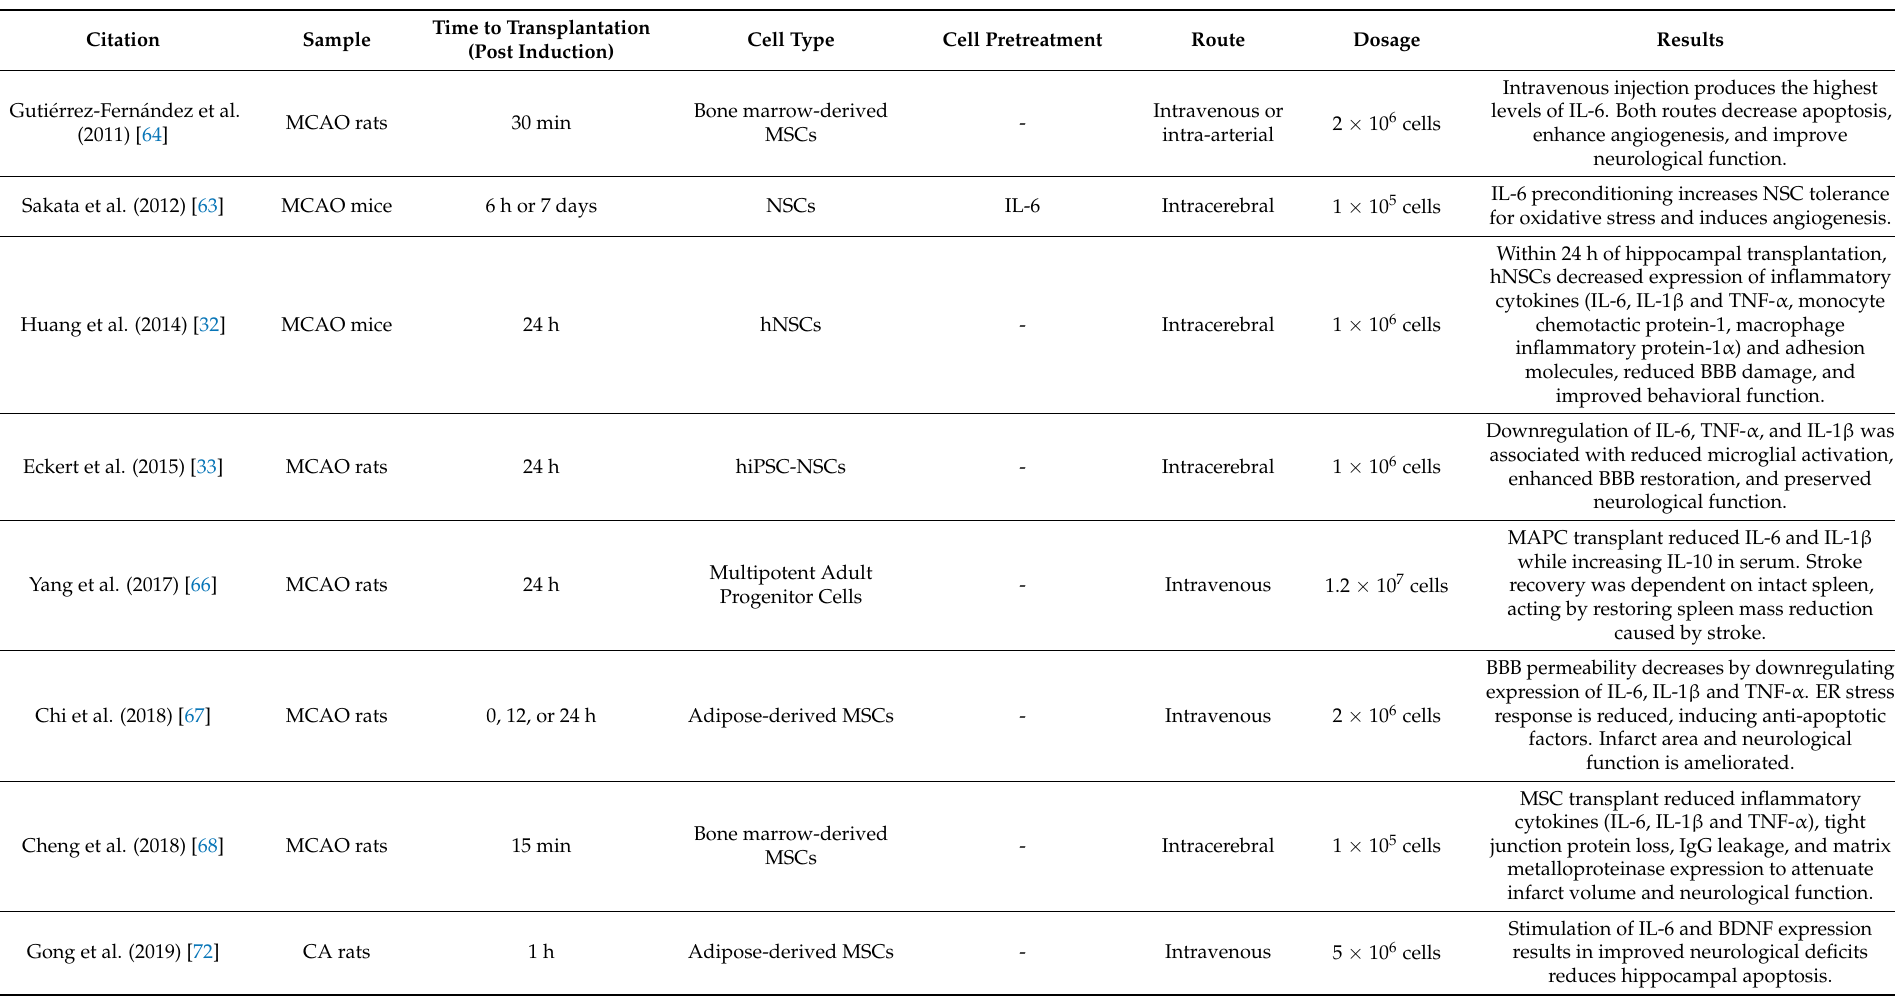
Table 1. In vivo Stem Cell Studies Affecting IL-6 Expression. This table outlines cell-based preclinical trials finding regulatory effects on IL-6 expression as a mechanism to enhance ischemic stroke